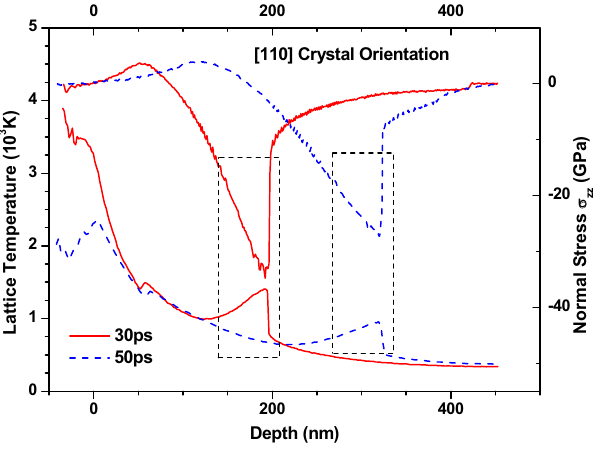
Figure 8. The contrast of spatial distributions of lattice temperature and normal stress ( σ zz ) in 450 nm 〈 100 〉 and 〈 111 〉 copper films under an absorbed laser intensity of 0.065 J/cm 2 at 10–50 ps time